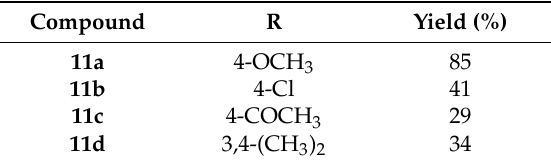
Table 2. Product yields for compounds 11a – d .